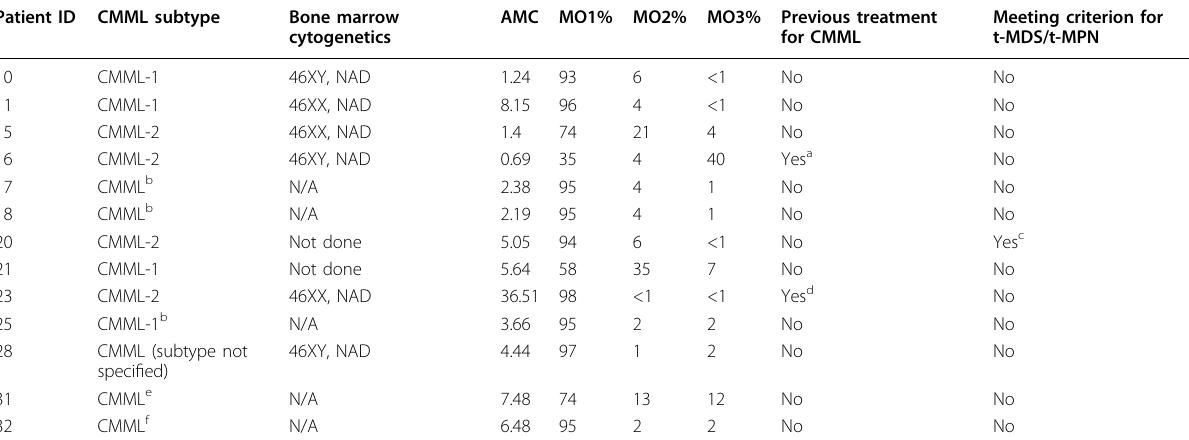
Table 1 Characteristics of patients with CMML ( n = 13). Patient ID CMML